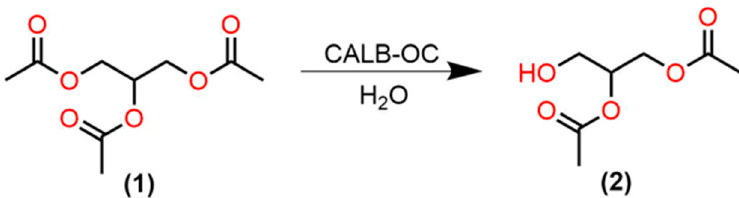
Figure 2. Regioselective hydrolysis of triacetin (1) to 1,2-diacetin (2) catalyzed by CALB-OC.